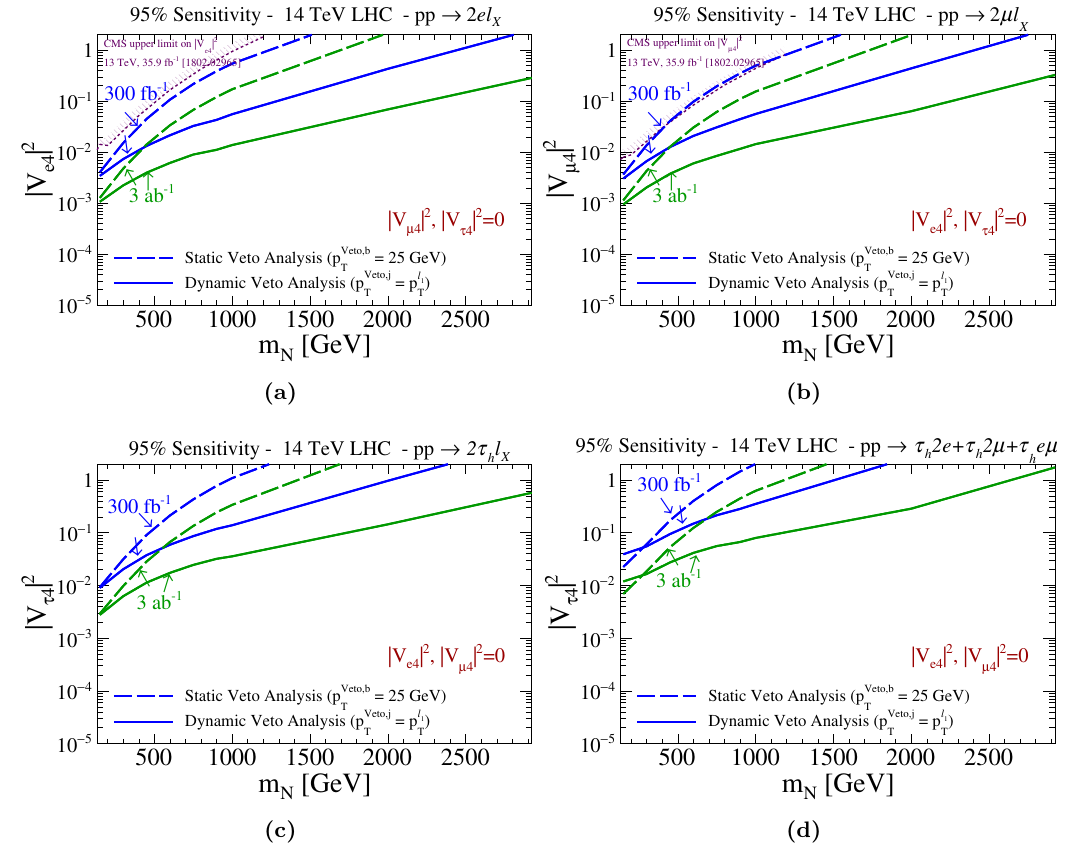
Figure 22. Same as (cid:12)gure 21 but for the charged lepton (cid:13)avor conserving signal categories (a) EE